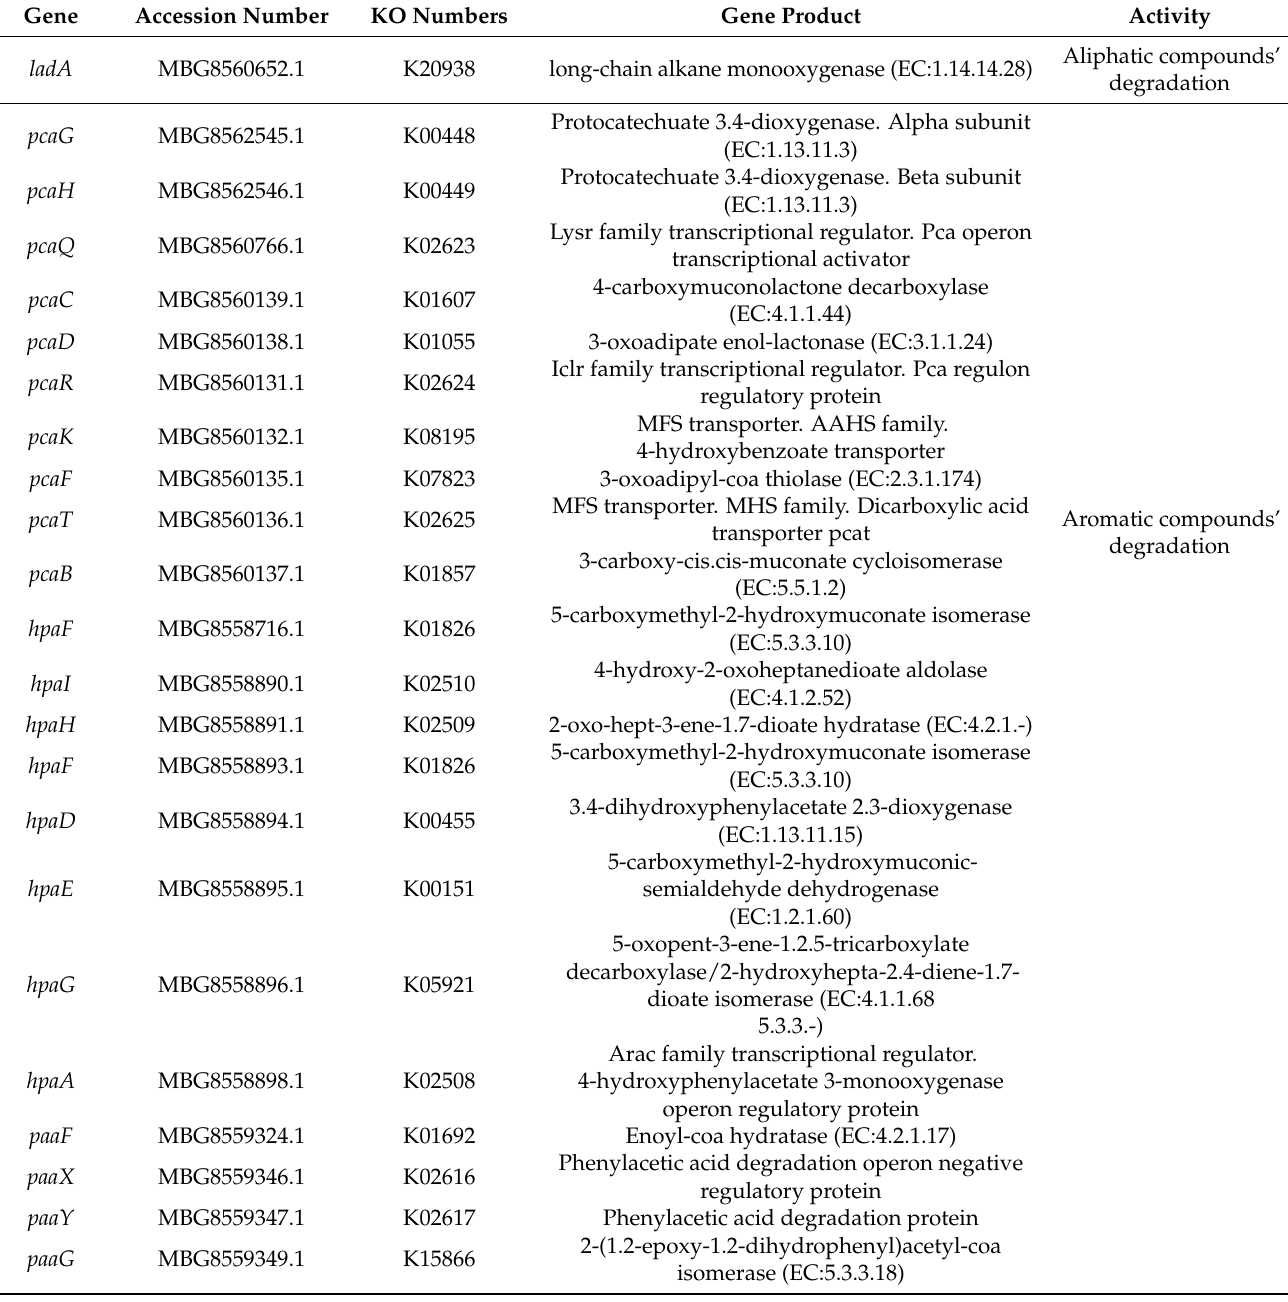
Table 8. Genes involved in organic compounds’